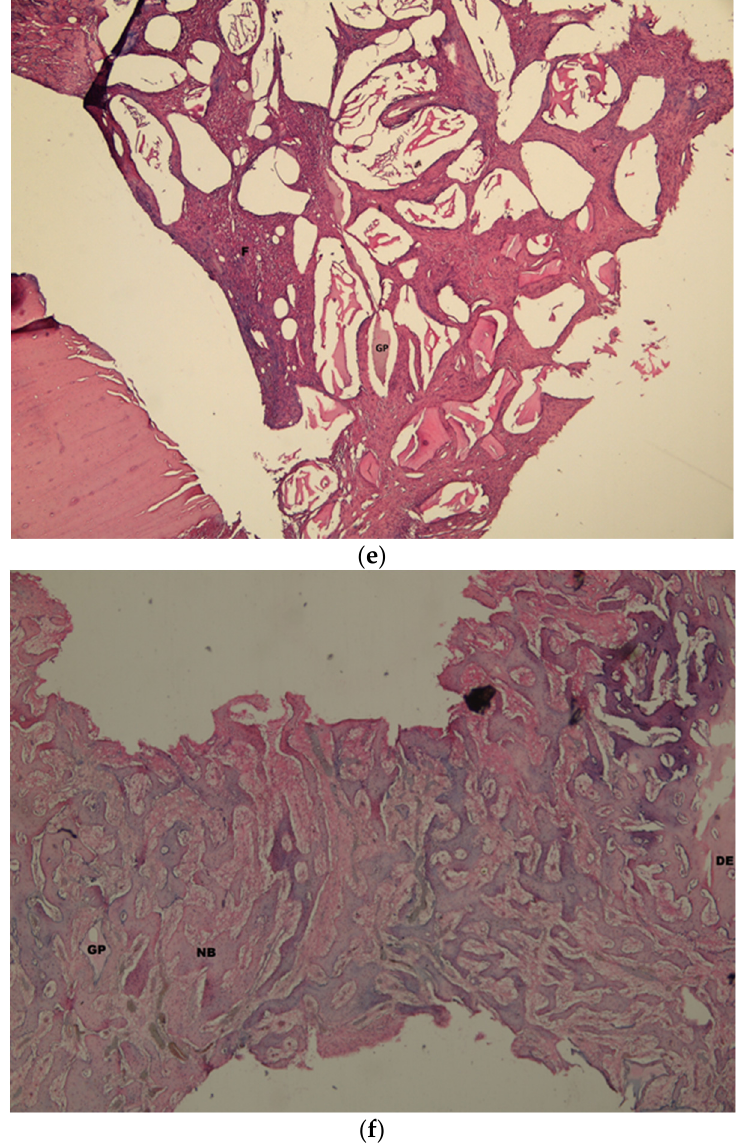
Figure 8. ( a ). Histological view of the empty defect group (group E) on the 3rd week, New bone formation (NB) was observed in the active connective tissue. H&E ×100. ( b ). Histological view of the autogenous group (group A) on the 3rd week. New bone formation (NB) and graft particles (GP) were seen starting from defect edge (ED), H&E ×100. ( c ). Histological view of the dentin group (group D) on the 3rd week. New bone formation (NB) and graft particles (GP) were observed near the defect edge (DE) H&E ×100. ( d ). Histological view of the xenograft group (group X) on the 3rd week. Large new bone formation (NB) and graft particle were determined in the middle of the defect. H&E ×100. ( e ). Histological view of the autogenous + xenograft group (group A+X) on the 3rd week. Mixed fibrosis (F) and graft particles (GP) were seen just near the defect edge (DE) H&E ×100. ( f ). Histological view of the dentin+xenograft group (group D+X) on the 3rd week. New bone formation (NB) and graft particles (GP) were observed between the defect edges (DE) H&E ×100. Increased new bone formation areas from the edges to the midsection of defects were observed on the 6th week (Figure 9a–f). The amount of graft particles was decreased and the particles were visible between new bone formation areas. Similar new bone formation rates were measured in groups D, X, A + X, D + X on the 6th week. Group E was observed to have the lowest rate of new bone formation (37.76 ± 1.99) which was statistically